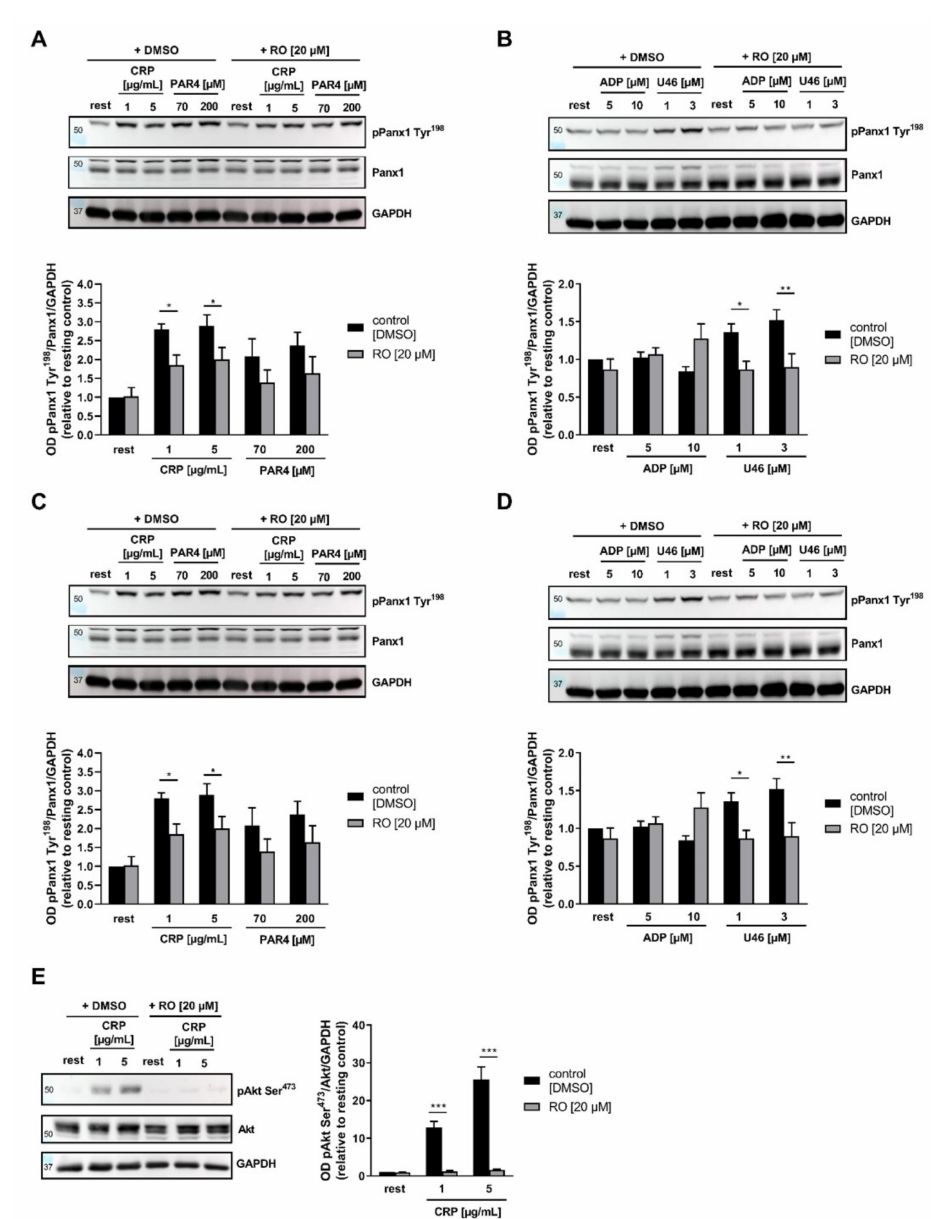
Figure 3. In addition to Src, PKC and Akt contribute to PANX1 activation by phosphorylation: ( A , B ) Representative immunoblot images and quantification of phosphorylation of PANX1 Tyr 198 after inhibition of PKC by pre-incubation of platelets with Ro-31-8220 (RO) or DMSO as a negative control. ( A ) Platelets were activated with 1 or 5 µ g/mL CRP and 70 or 200 µ M PAR4 ( n = 3) of ( B ) with 5 or 10 µ M ADP and 1 or 3 µ M U46619 ( n = 4). ( C , D ) Representative Western blot images and quantification of phosphorylation of PANX1 at Tyr 198 after inhibition of Akt1/2 by pre-incubation of platelets with 20 µ M Akti1/2 or DMSO as a negative control. ( C ) Platelets were activated with 1 or 5 µ g/mL CRP and 70 or 200 µ M PAR4 peptide ( n = 4) and ( D ) with 5 or 10 µ M ADP and 1 or 3 µ M U46619 ( n = 3). ( E ) Representative Western blot images and quantification of phosphorylation of Akt at Ser 473 after inhibition of PKC by pre-incubation of platelets with RO or DMSO as a negative control ( n = 4). Platelets were activated with 1 and 5 µ g/mL CRP. Statistical analyses were performed using a two-way ANOVA followed by a Sidak’s multiple comparisons post-hoc test. Bar graphs indicate mean values ± SEM, * p < 0.05; ** p < 0.01 and *** p < 0.001. Rest = Resting, CRP = Collagen-related peptide, PAR4 peptide = Protease-activated receptor 4 peptide, ADP = Adenosine diphosphate, U46619 (U46) = Thromboxane analogue, PKC = Protein Kinase C, DMSO = Dimethyl sulfoxide, Akti1/2 = Akt1/2-inhibitor, RO =